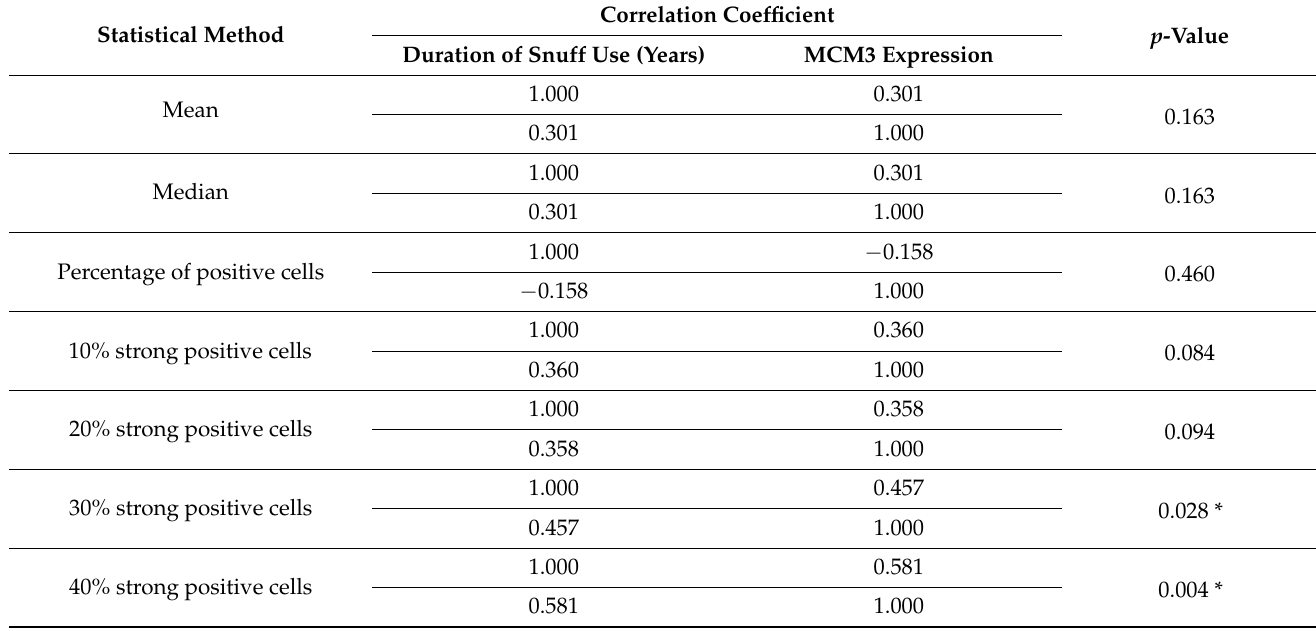
Table 11. Association of duration of snuff use with MCM3